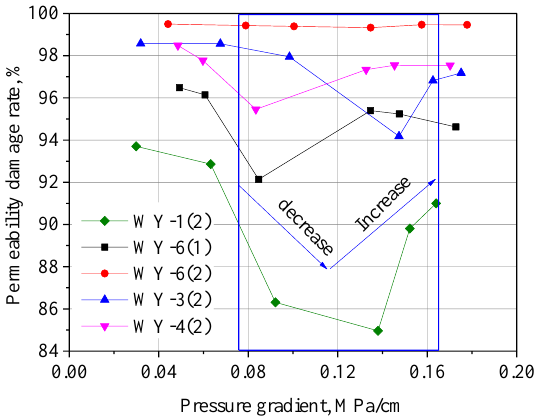
Figure 7. Relationship between pressure gradient and permeability damage rate of five shale sam- ples.